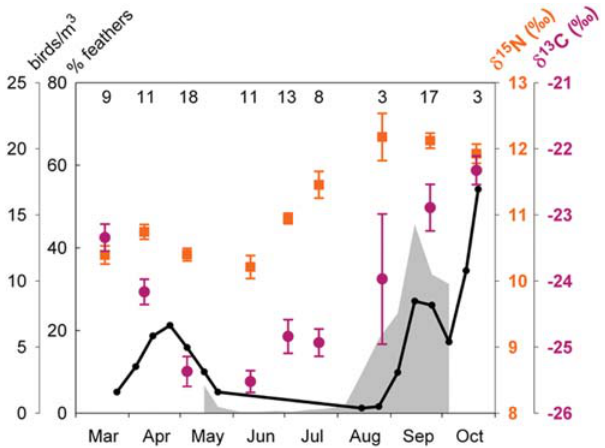
Figure 3. Seasonal variation in isotopic composition of blood of Nyctalus lasiopterus. Means 6 SE for d 13 C (purple circles) and d 15 N (orange squares) for each sampling event are given. Numbers at the top of the figure designate sample size. The black line indicates nocturnal migration density of small passerines tracked by radar in southern Spain [29]. The shaded area represents proportion of feathers found in faecal pellets of Nyctalus lasiopterus [17].